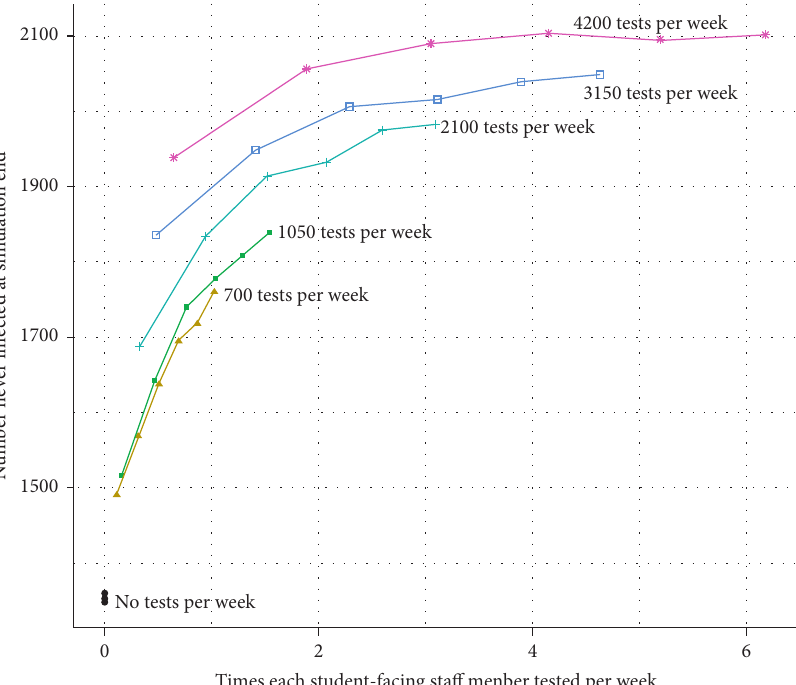
Figure 6: Health outcomes for six different testing configurations showing a trade-off between the weekly total number of tests and the testing frequency for student-facing staff. In this figure, each curve is a line of fixed cost, illustrating that better health outcomes can be achieved for lower cost, depending on how testing is